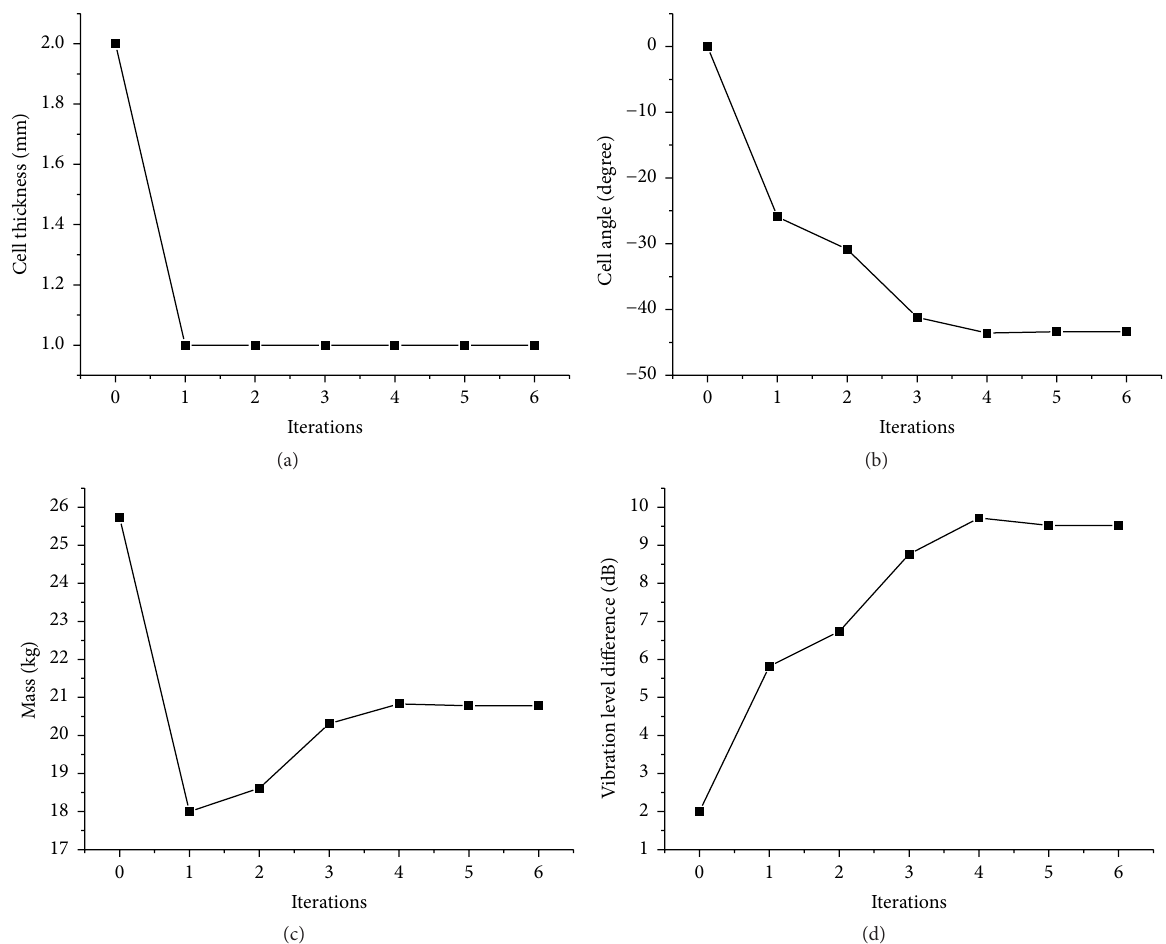
Figure 9: Iteration curve of (a) cell thickness, (b) cell angle, (c) mass of honeycombs, and (d) vibration level difference.